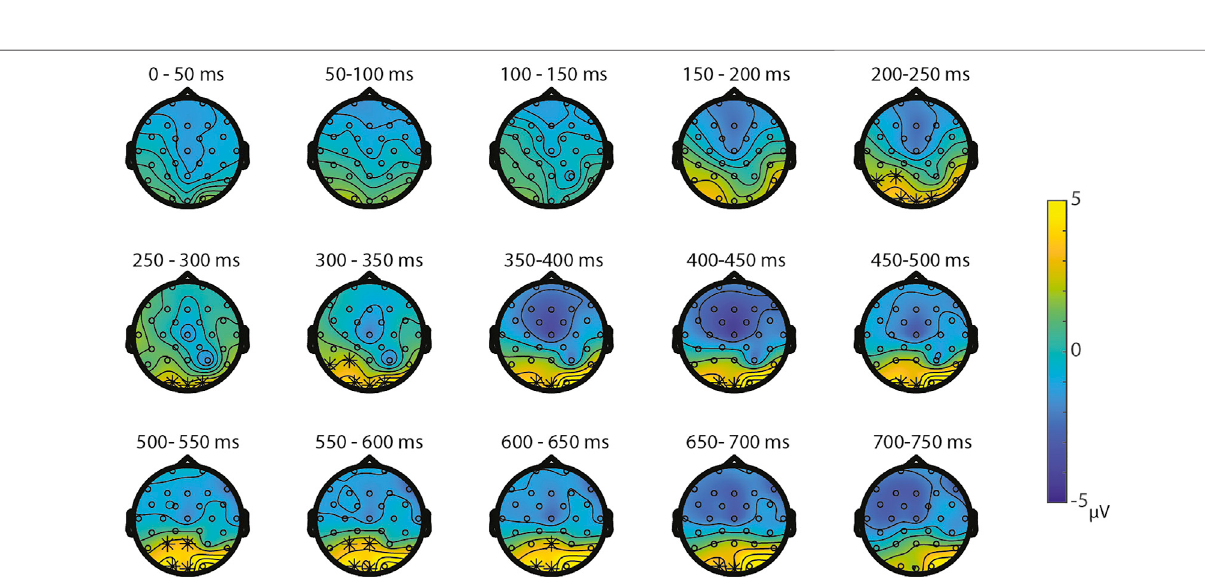
Frontiers in Education |